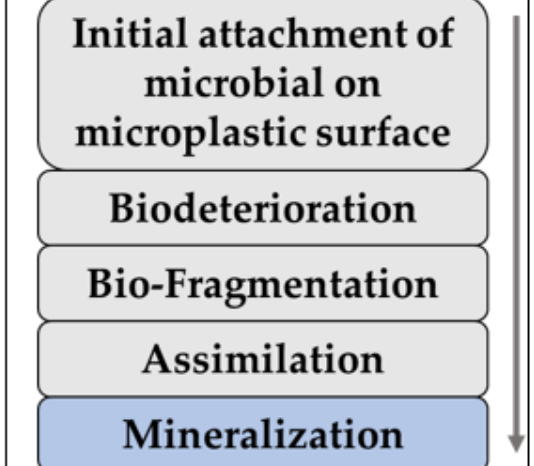
Figure 4. Steps in biotic degradation of microplastics.